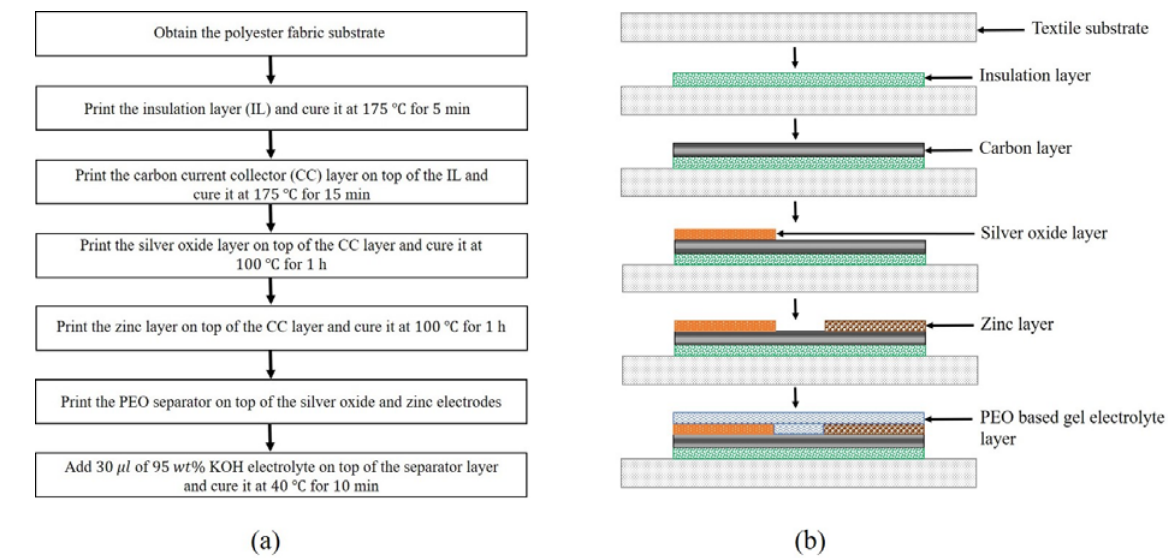
Figure 1. ( a ) Flow chart illustrating the battery fabrication procedure and ( b ) cross-sectional view of the corresponding printed layer at each fabrication step.